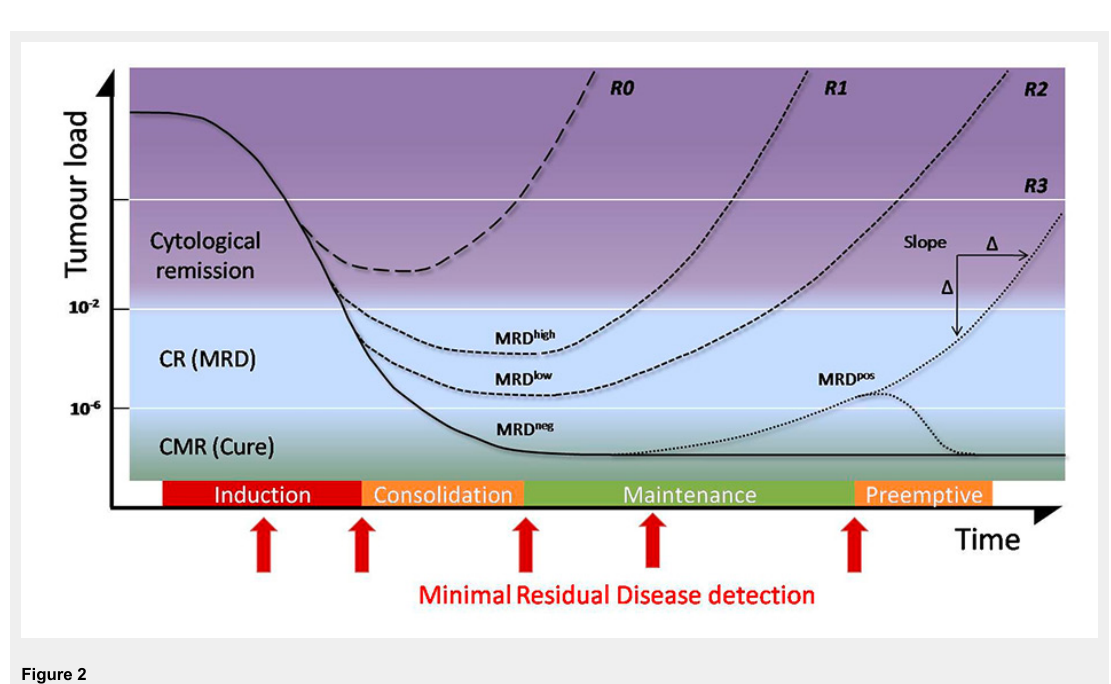
Evolution of tumour load and minimal residual disease (MRD) before, during and after chemotherapy. After therapy, the level of MRD is one of the best predictive factors of relapse. A patient who did not achieve MRD level will relapse very quickly (R0). Depending of the level of minimal disease present, relapse will occur sooner or later (R1, R2, R3). Patients who achieve MRD negativity are considered to be cured and can be maintained in that state with pre-emptive treatment triggered by MRD positive results. The slope of the tumour growth curve is a further predictive